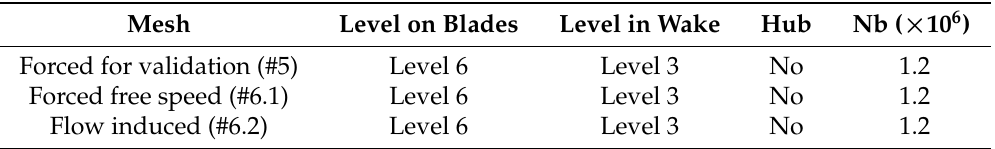
Table 3. Summary of test cases for vertical axis turbine according to the level of refinement on the blades and in the wake, the presence or absence of a hub, and the total number of points in the mesh (Nb).